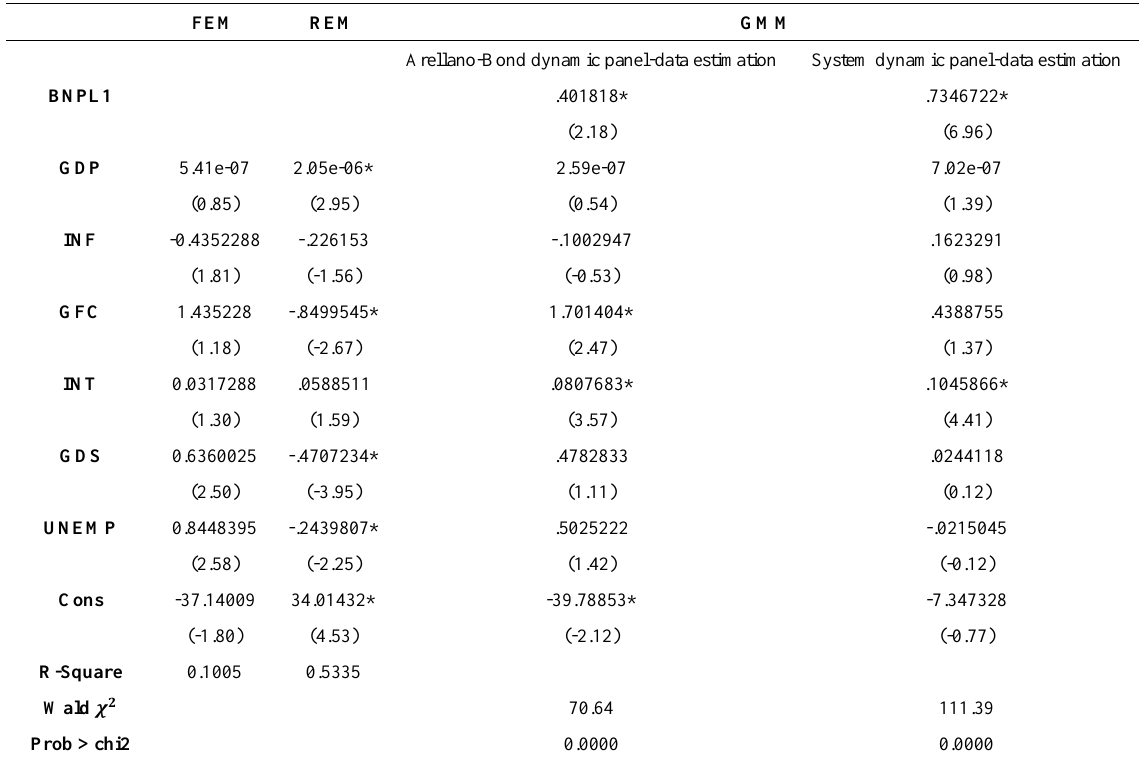
Table 3. Results of regression